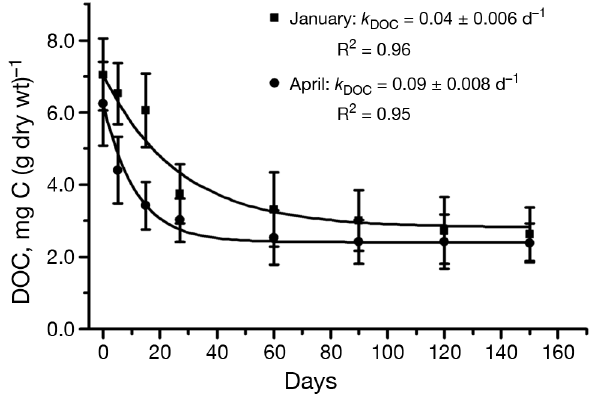
Fig. 6. Decay of bioavailable dissolved organic carbon (BDOC) from sample water collected during the January and April incubations. The solid line represents the predic- tions of the exponential decay model, values are mean ± SD, n =